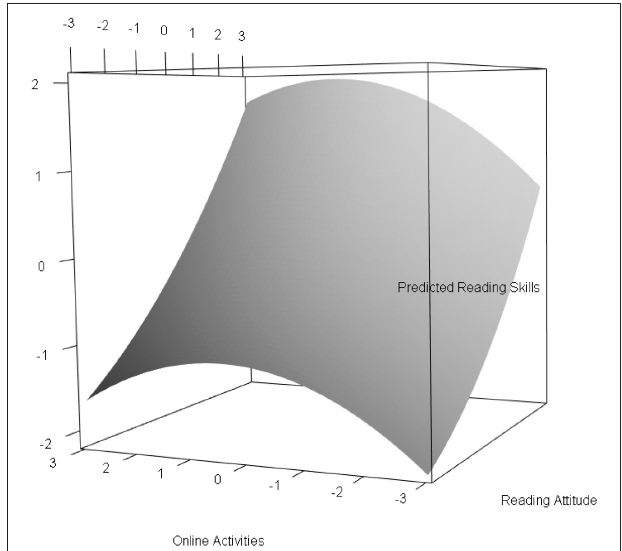
FIGURE 2 | Standardized multivariate relationship between reading attitude, online activities and reading skills.